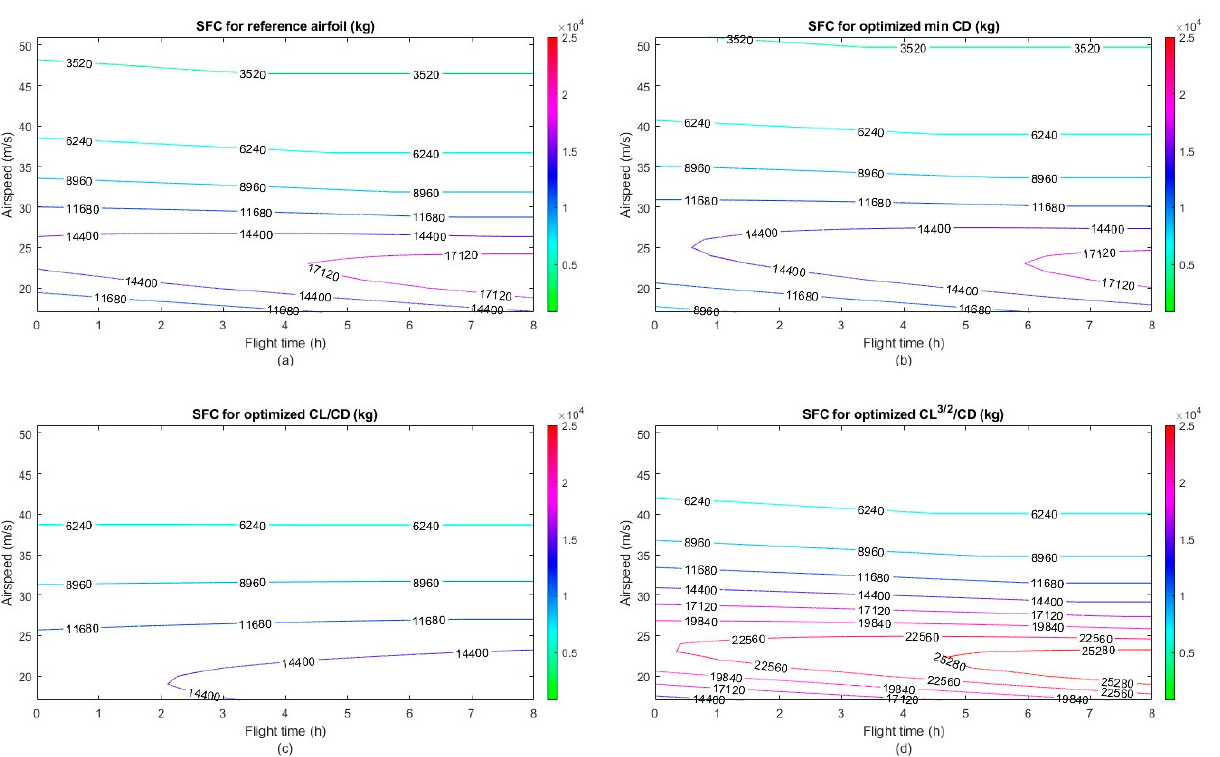
Figure 20. Comparison of specific fuel consumption with flight time at different speeds for the reference and optimized UAS-S45. ( a ) SFC for reference airfoil, ( b ) SFC for optimized min CD, ( c ) SFC for optimized CL/CD, ( d ) SFC for optimized CL 3/2 /CD.